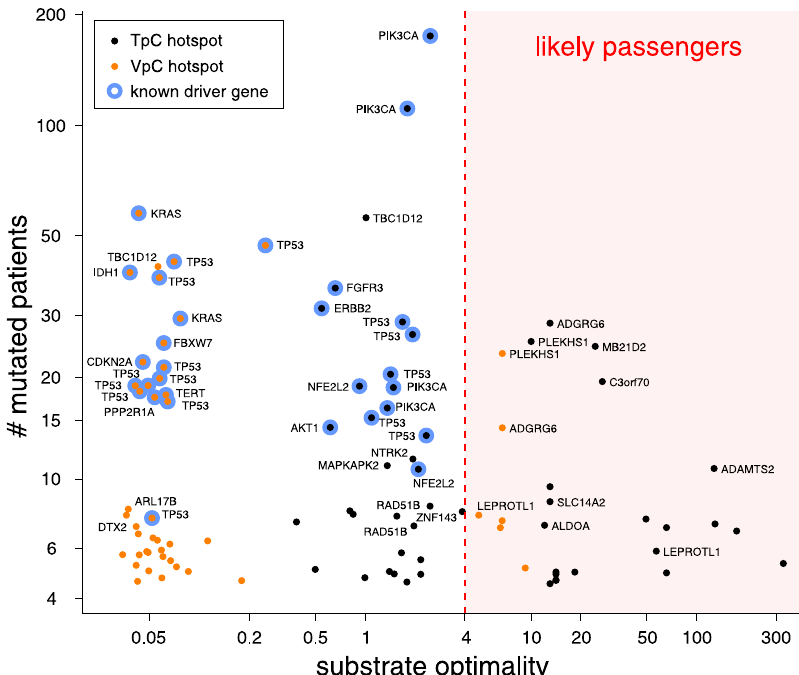
Fig. 5 VpC passenger hotspots. The top 100 mutation hotspots in a set of APOBEC + tumors. The x -axis represents substrate optimality, the expected mutation frequency relative to the baseline mutation rate at all linear TpC sites. The y -axis represents the number of patients in this cohort carrying a mutation at that site. Hotspots at optimal hairpin substrates for APOBEC3A ( x ≥ 4) are likely passenger hotspots, whereas hotspots at ordinary sites ( x < 4) are known or likely drivers. VpC hotspots in PLEKHS1 and ADGRG6 (also called GPR126 ) can now be understood to be optimal APOBEC3A hotspots despite their non-canonical primary sequence. Source data are provided as a Source Data fi